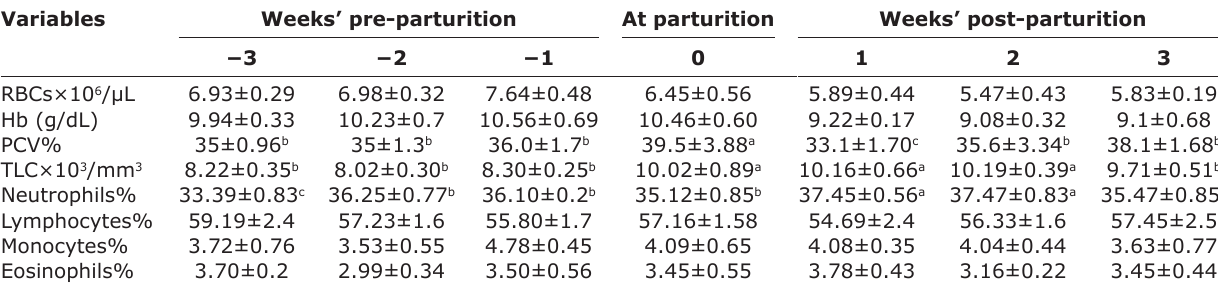
Table-1: Hematological parameters before and after parturition and on the day of parturition at the following time points.